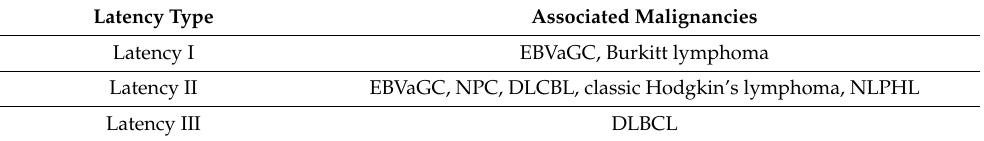
Table 1 summarizes the EBV protein expression seen in each type of latency. “+” indicates the protein is expressed, while “ − ” indicates that the protein is not expressed. Table 2. EBV latency patterns and associated